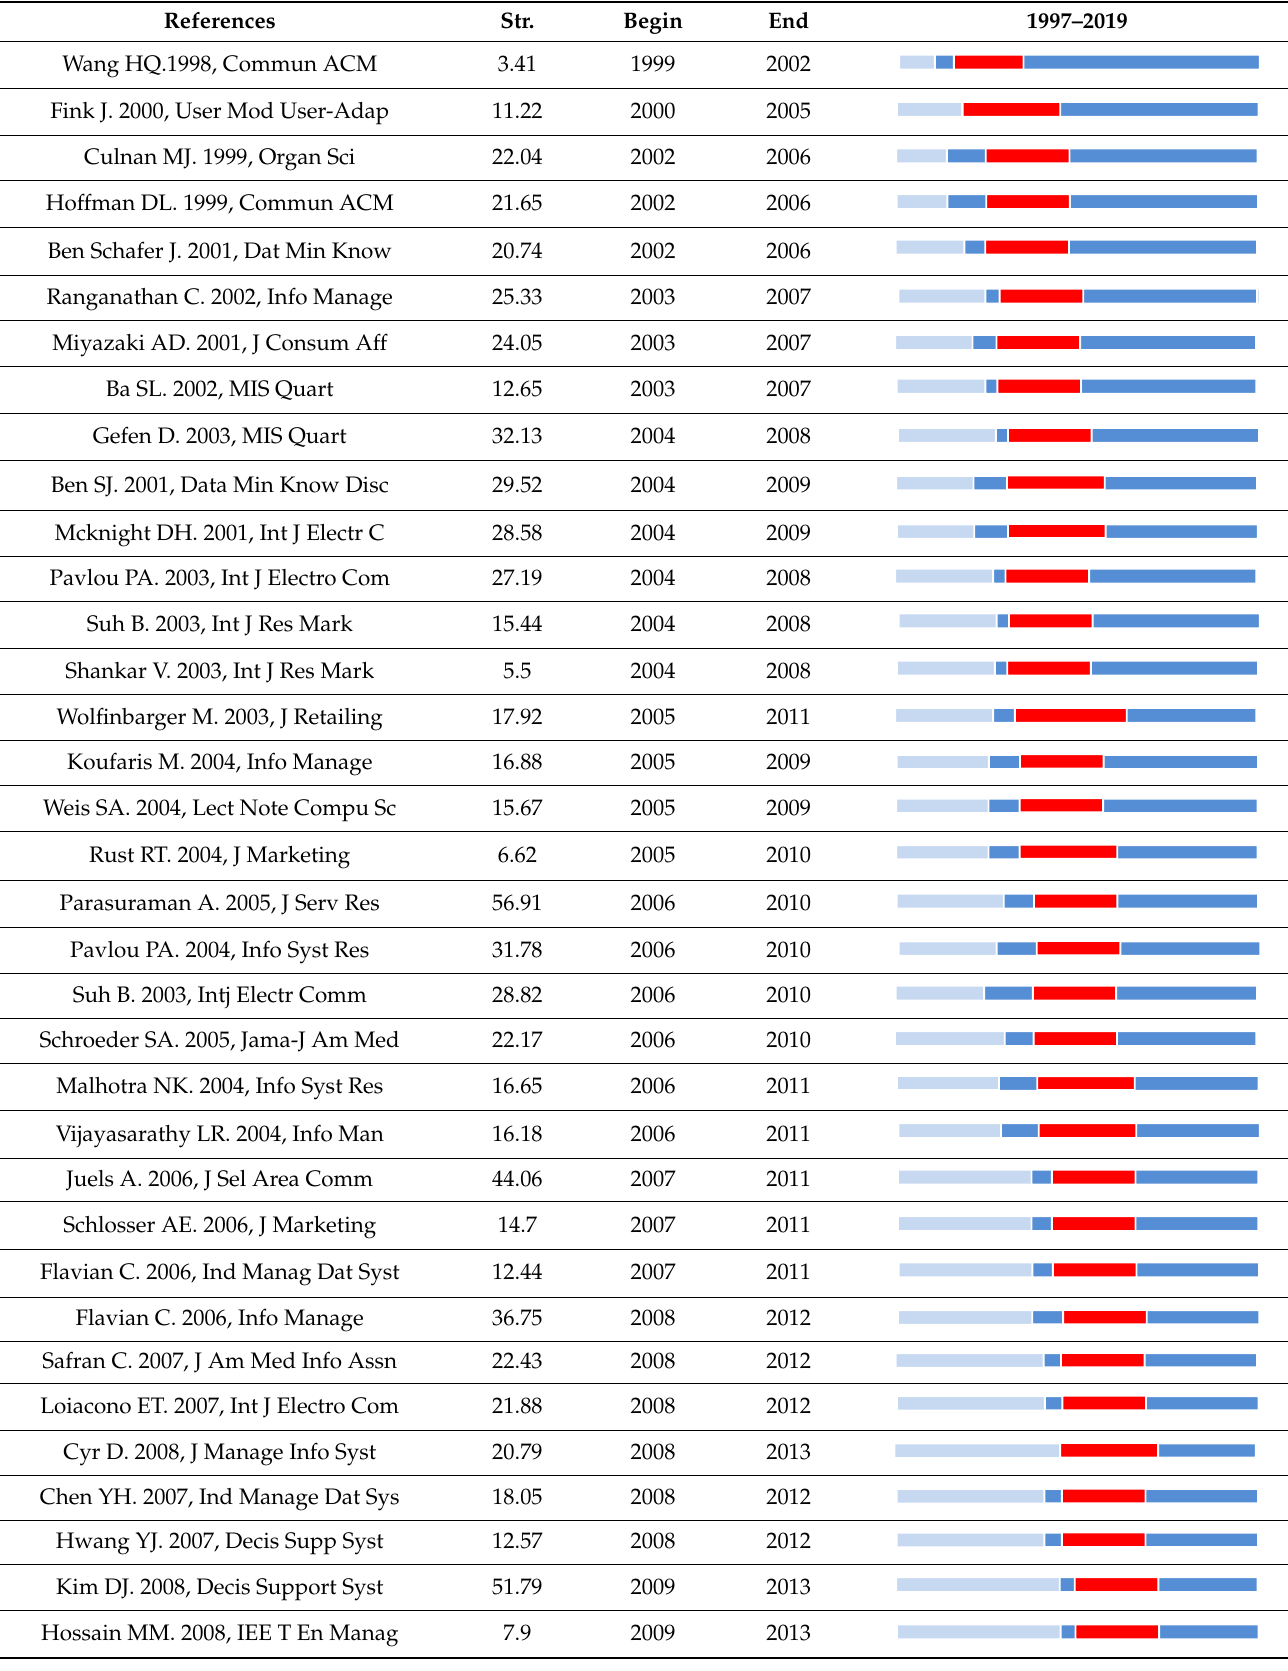
Table 6. Top 43 references with the strongest citation bursts.